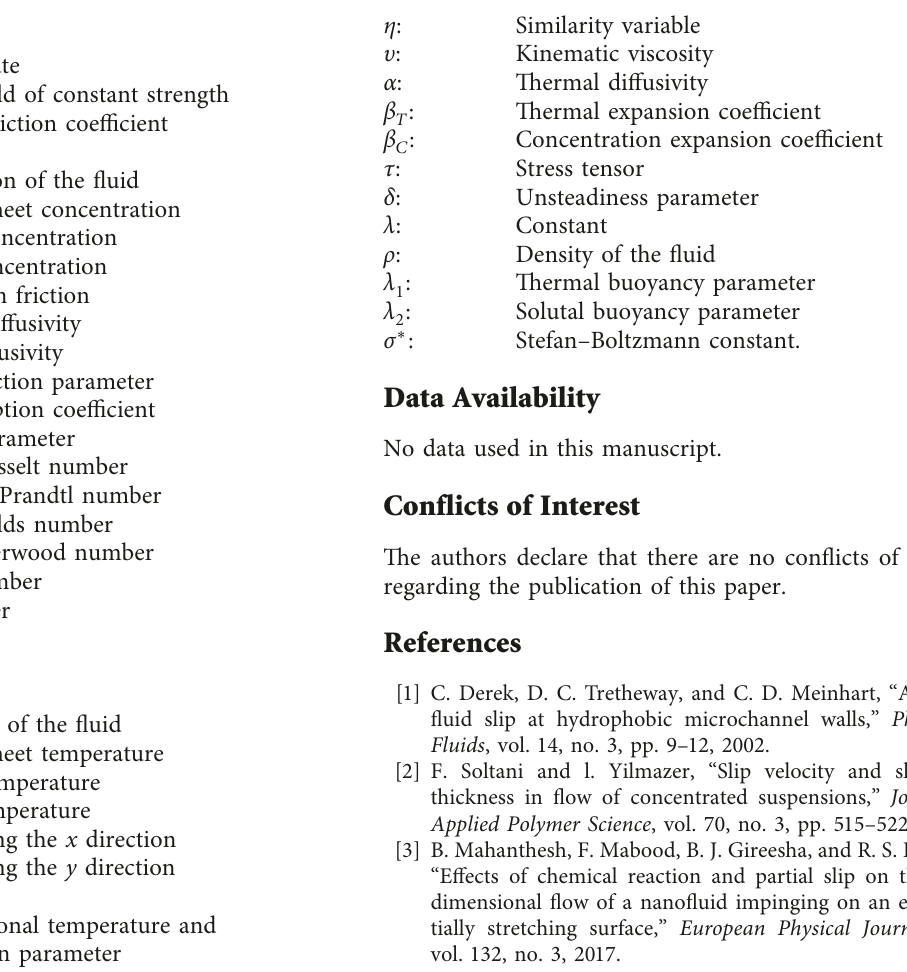
, δ ,M , and f ϕ w on the reduced Sherwood